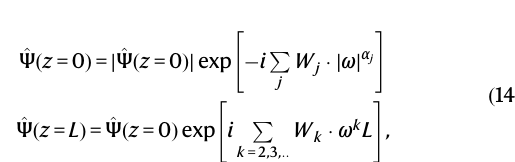
ComparingEq.(9)totheexperimentalresultspresentedinFig.3a,